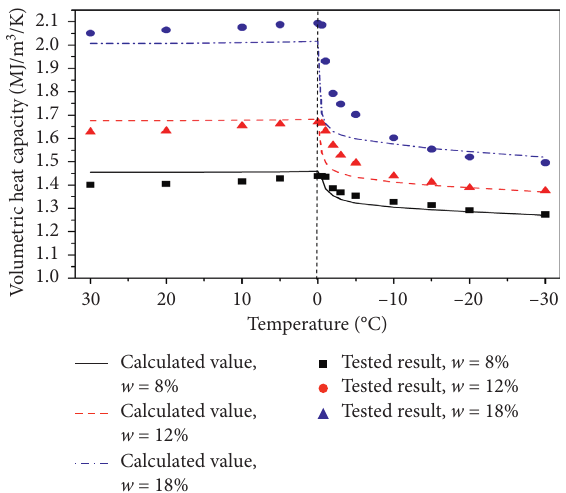
Figure 8: Comparison between the tested results and the calculated values.